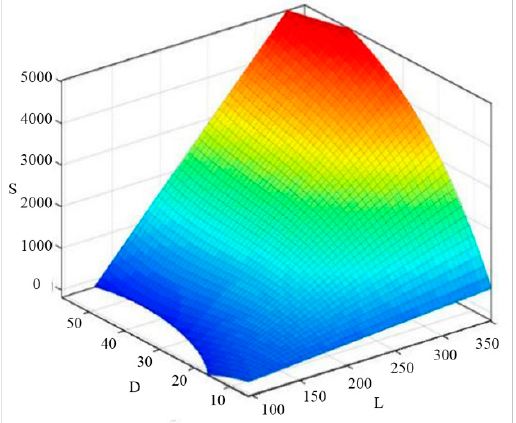
Figure 13. Three-dimensional space model of factors (L, D) and responses